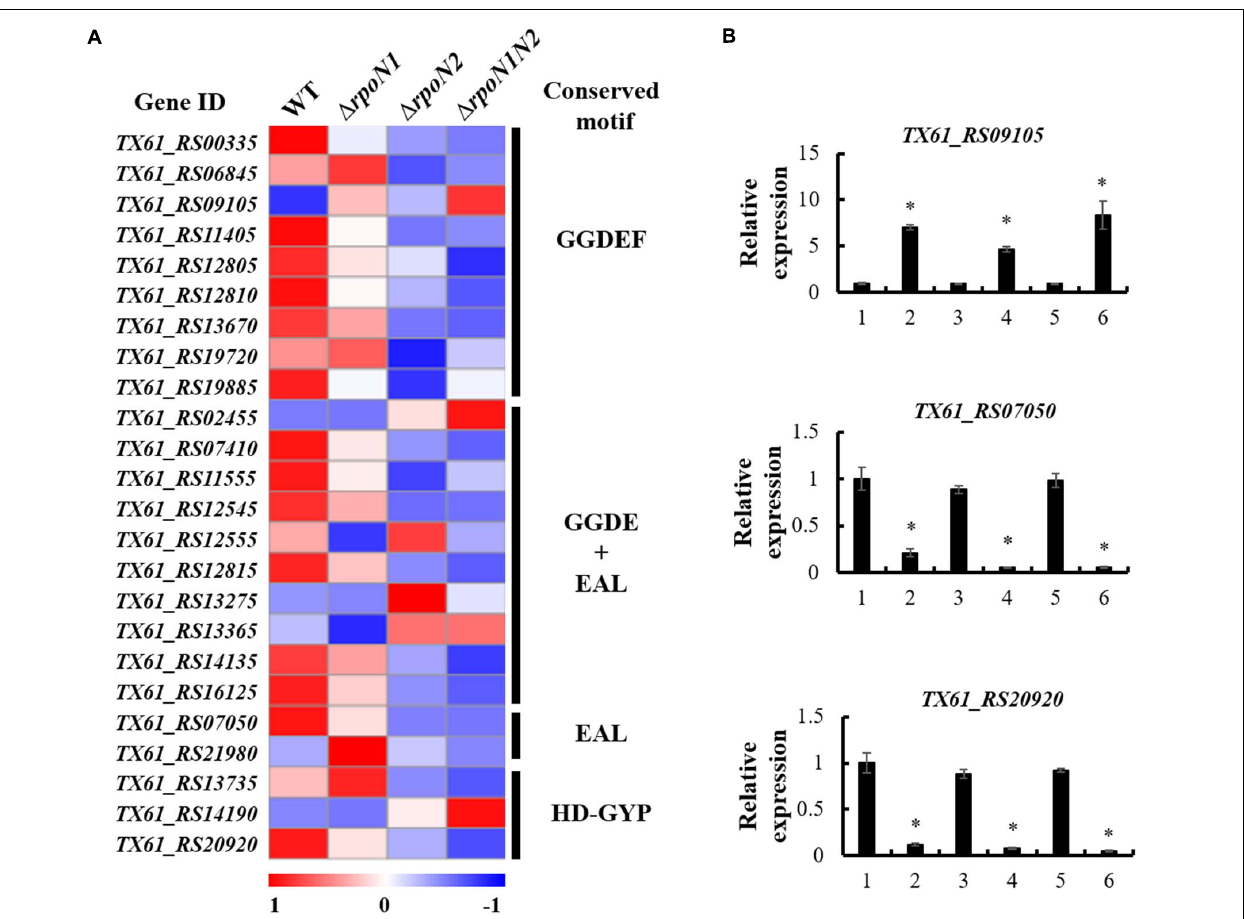
FIGURE 8 | RpoN1 and RpoN2 regulated the expression of c-di-GMP associated genes. (A) Heat map of c-di-GMP associated gene expression. (B) The expression patterns of TX61_RS09105 , TX61_RS07050 , TX61_RS20920 in (cid:49) rpoN1 , (cid:49) rpoN2, and (cid:49) rpoN1N2 were validated by qRT-PCR. 1, WT; 2, (cid:49) rpoN1 ; 3,